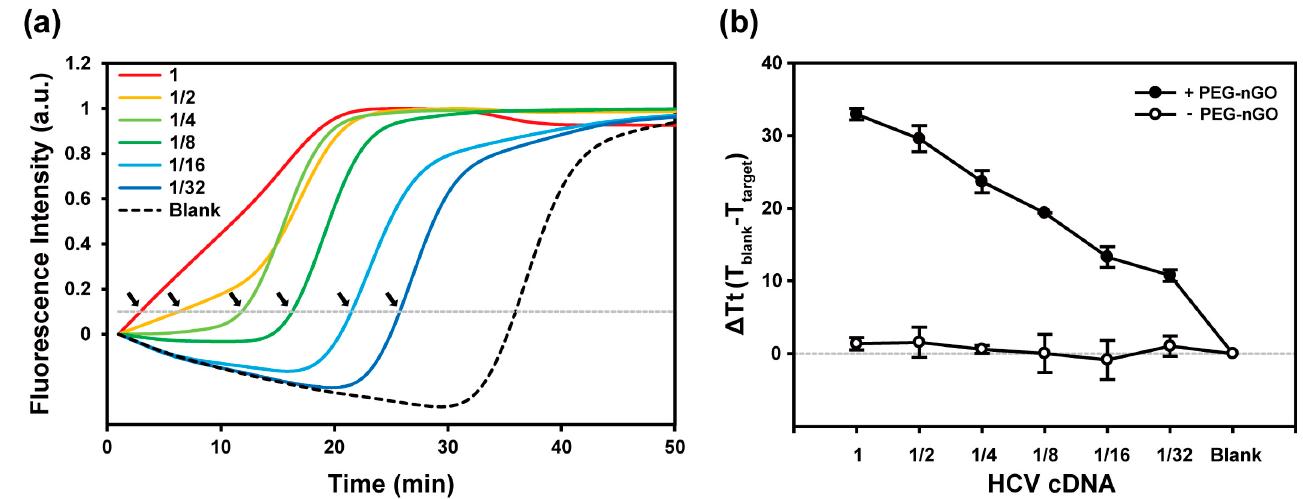
Figure 3. Effect of PEG-nGO on LAMP sensitivity. ( a ) Real − time fluorescence monitoring of PEG- nGO-based LAMP − amplified products with serially diluted concentrations of target cDNA shown with arrows (ranging from 1 − fold to 1/32 − fold; 1 − fold depicts the cDNA transcribed from HCV − positive serum without dilution). ( b ) Comparison of Δ Tt (Tt of blank—Tt of target) values of serially diluted target cDNA with or without PEG-nGO. Average Δ Tt values are obtained from serially diluted cDNA with or without PEG-nGO, and the error bars display the standard deviation.